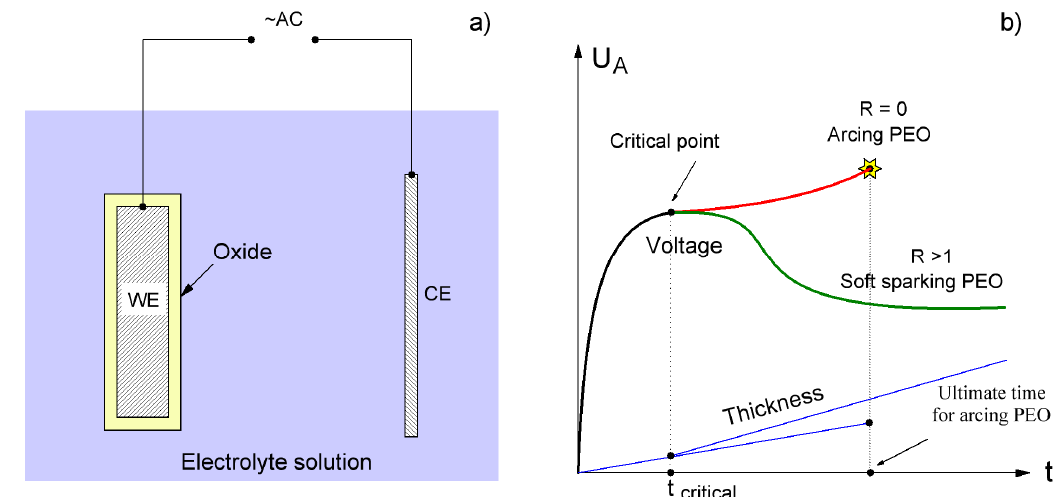
Figure 1. Schematic view of electrochemical cell ( a ) and evolution of anodic (positive) voltage peak (envelope of the positive pulses) and coating thickness during plasma electrolytic oxidation (PEO) processes of Al under current control ( b ). Value R = J n /J p is the ratio of negative to positive current densities.